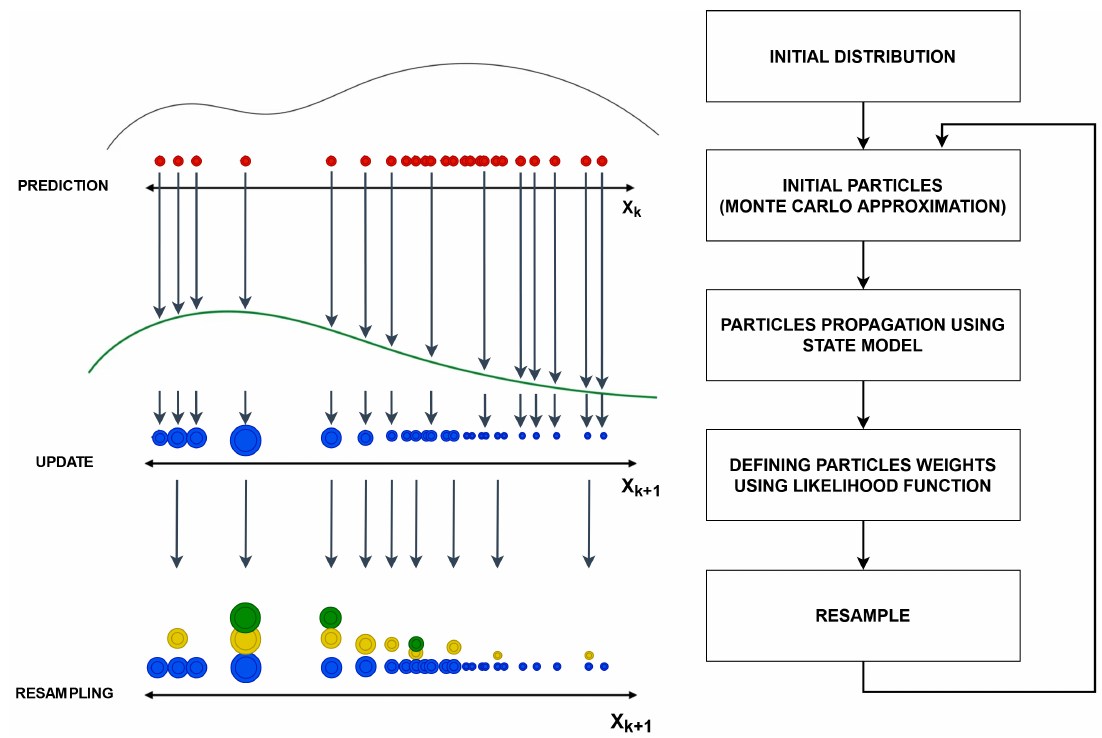
Figure 14. The main principle of particle flow in the Particle filter (PF)